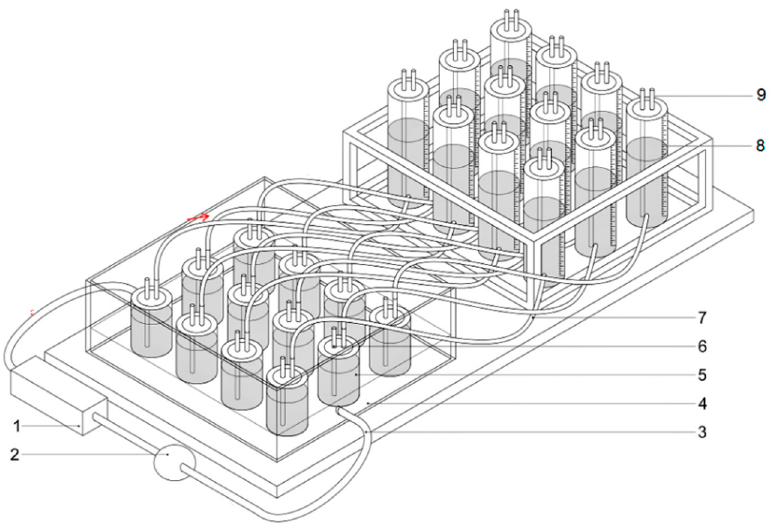
Figure 2. The bioreactor (12-chamber section) used in biogas production experiment: 1—water heater; 2—water pump; 3—insulated tubes for heating medium; 4—water jacket (39 °C); 5— bioreactor (1.4 L); 6—slurry sampling valve; 7—tube for biogas transport; 8—graduated tank for biogas; 9—gas sampling valve (Adapted with permission from Ref. [12]. 2019, Molecules, Multidisciplinary Digital Publishing Institute, Basel, Switzerland).